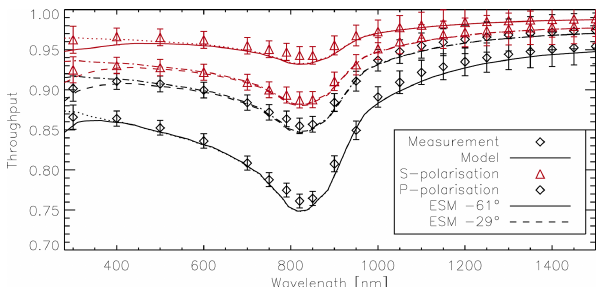
Figure 8. SCIAMACHY scan mirror reflectance for different po- larisations ( S and P ; i.e. Q = 1 and Q = − 1) of the incident light and for different incident angles. Measurements during on-ground calibration are shown as diamonds. The curves represent the re- flectance according to the mirror model, using an aluminium mirror with 4.1nm aluminium oxide and 0.4nm light oil contamination, under an angle of incidence of either 29 ◦ (dashed) or 61 ◦ (solid). Dotted and dash–dotted curves indicate the reflectance of clean alu- minium instead as a